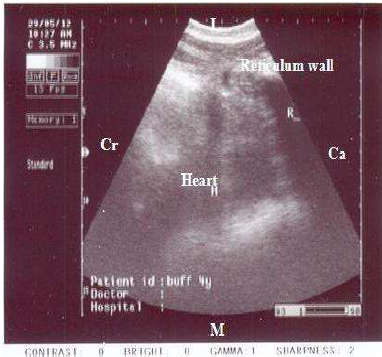
Figure-9. Lateral plain radiography of the cranial abdominal and caudal thoracic regions in 5-year- old buffalo showing radio-opaque metallic foreign body- long needle (1) at the caudal border of the heart (2), reticulum (3) and lung (4). The case was diagnosed as traumatic pericarditis.